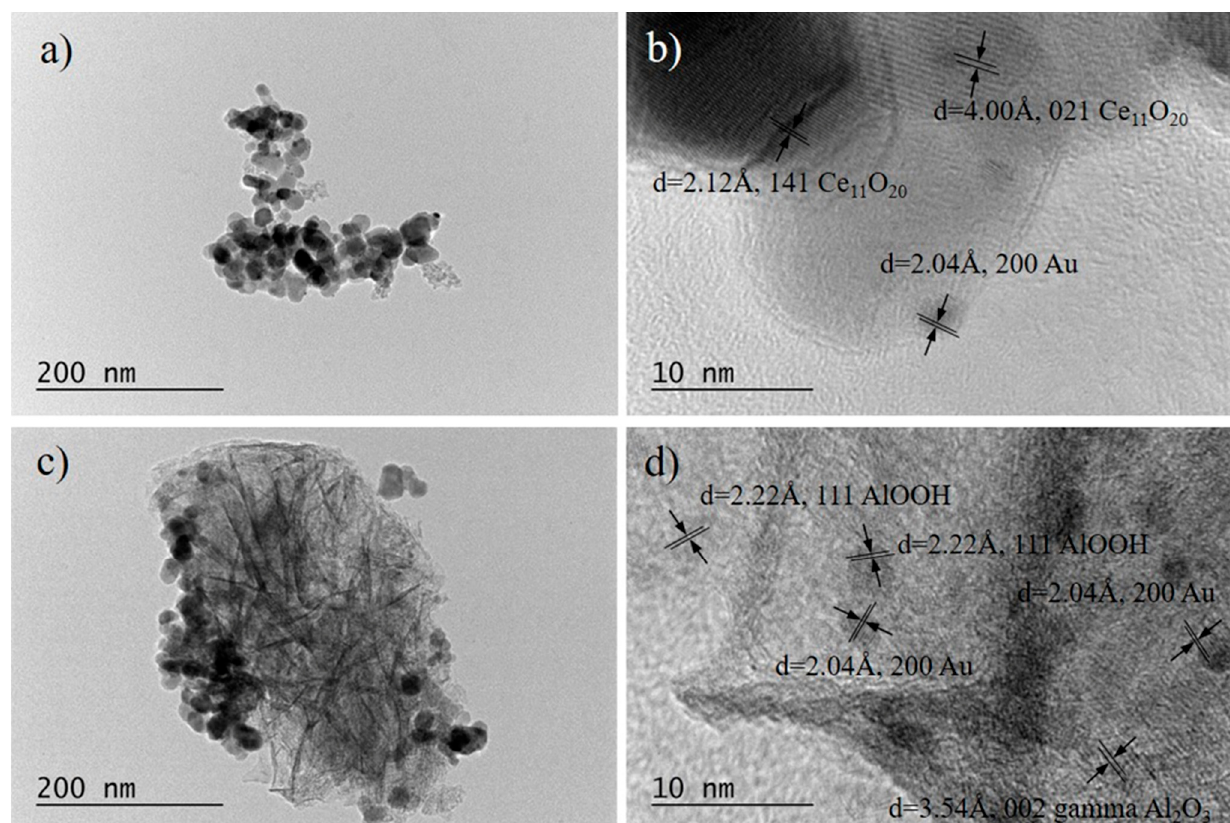
Figure 4. TEM images at magnification 40,000× ( a , c ) and the corresponding HRTEM images at mag- nification 600,000× ( b , d ) for two different zones of Au/Co-Ce/Al